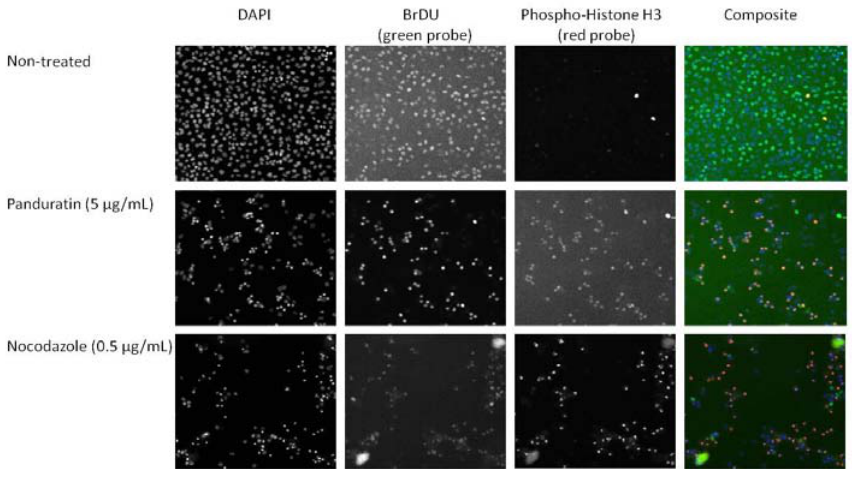
Figure 5. Staining of BrdU and hosphor-Histone H3 in A549 cells. S-phase cells were detected with BrdU staining, and mitotic cells were stained with hosphor-Histone H3 antibody. Cell images were acquired using the cellomics HCS Reader with a 10X objective lens.